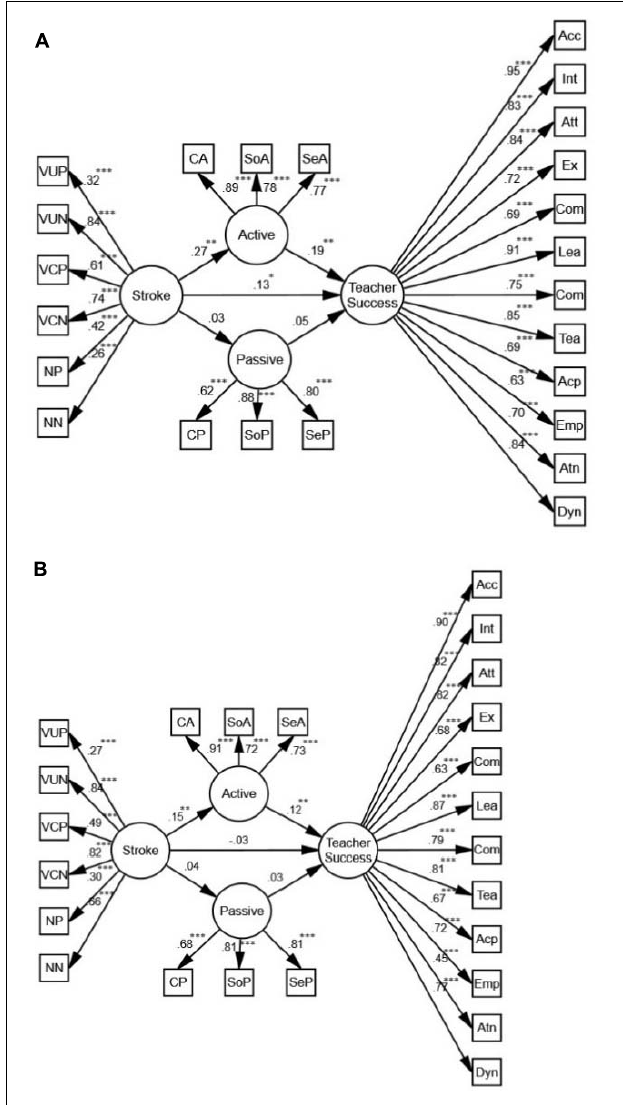
FIGURE 3 | (A) The schematic representation of the relationships between stroke, active and passive motivation, and teacher success (Females). (B) The schematic representation of the relationships between stroke, active and passive motivation, and teacher success (Males) (** p < 0.01, *** p <